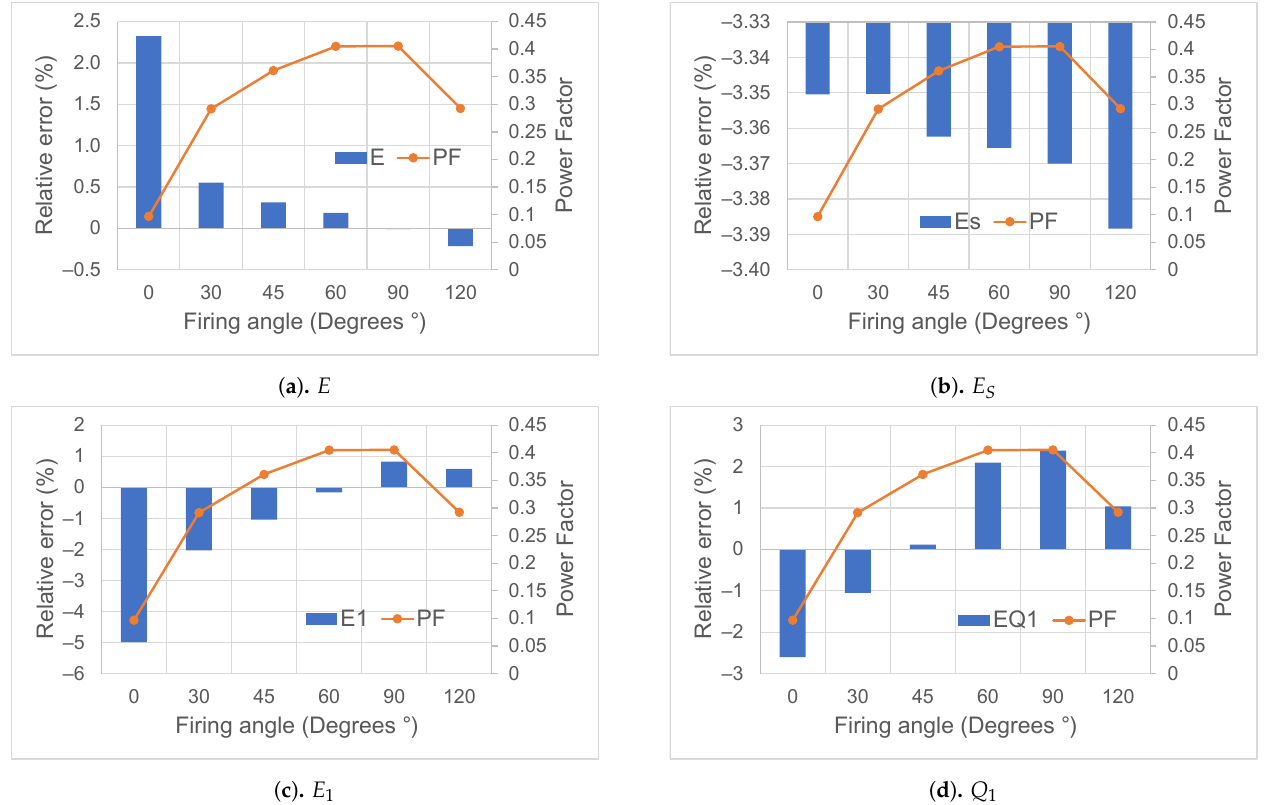
Figure 16. Relative error vs. firing angle: ( a ) total active energy; ( b ) total apparent energy; ( c ) fundamental active energy; and ( d ) fundamental reactive